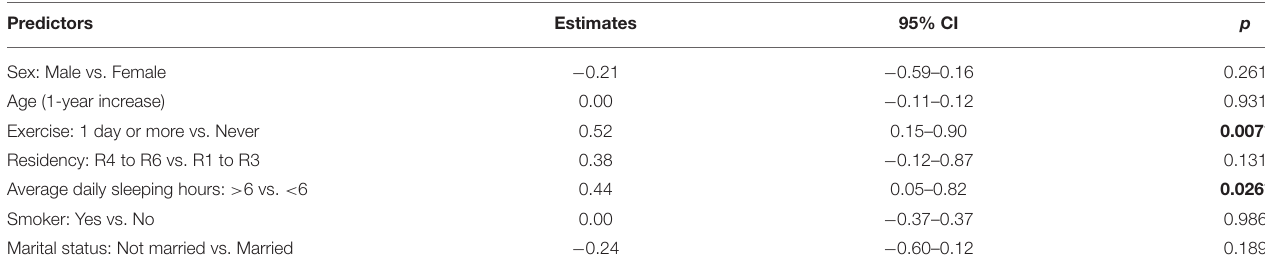
TABLE 4 | Factors associated with the total emotional intelligence score.